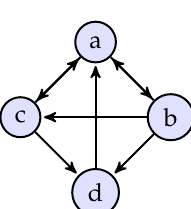
Figure 3. A strongly connected communication graph with 4 vertices, 6